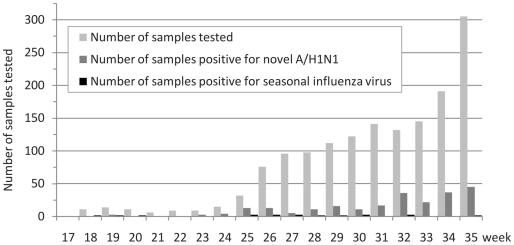
Weekly distribution of samples tested and samples positive for H1N1sw or seasonal H3N2 virus.